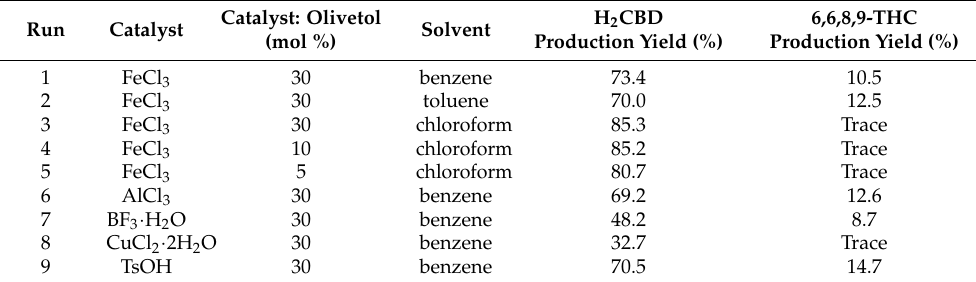
Table 1. Reaction condition screening for H 2 CBD production.